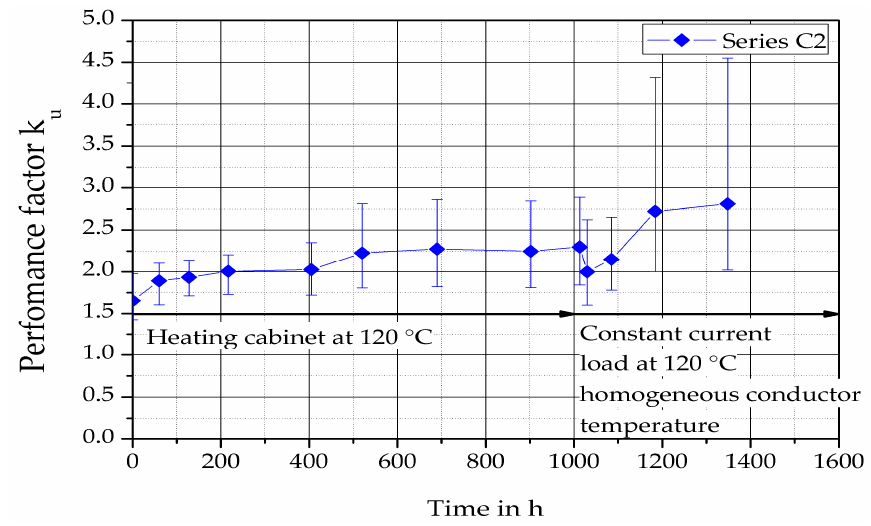
Figure 6. Performance factor k u of clinch joints depending on the time in accordance with